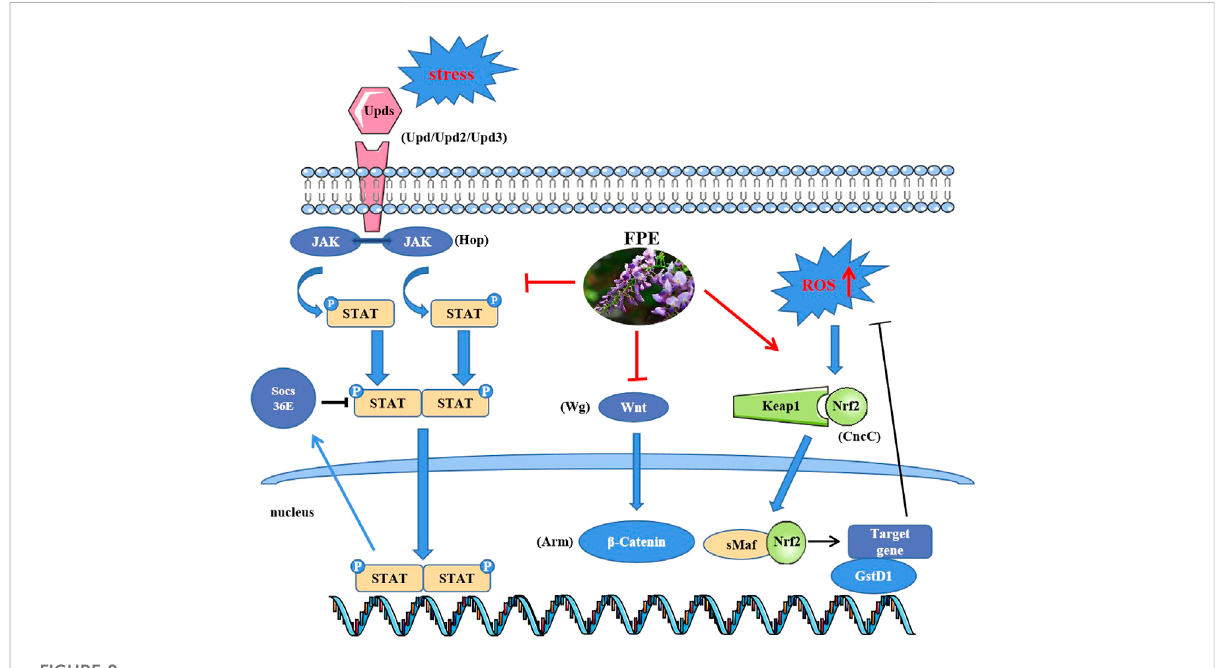
FIGURE 8 Functional mechanism of FPE in the treatment of